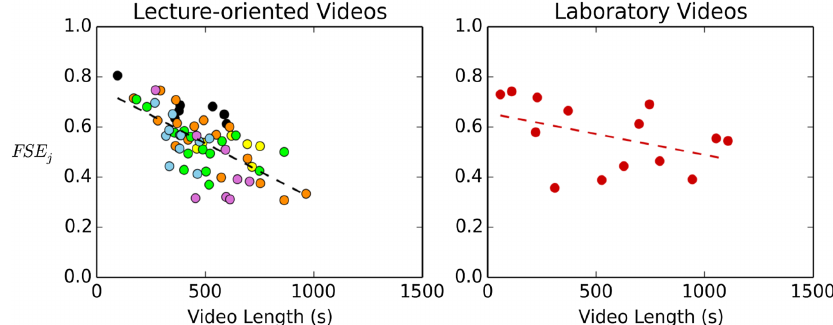
FIG. 5. Video length vs fraction of students accessing more than 99% of the given video (FSE j ). Each data point represents one single video in the course. The lecture-oriented videos are color coded based on different topics, with black, orange, yellow, green, blue, and purple representing the 1st to 6th topics presented in Table II, respectively. The trend lines for all lecture-oriented videos combined and all laboratory videos combined are y ¼ − 0 . 000 447 x þ 0 . 758 and y ¼ − 0 . 000 167 x þ 0 . 655 , respectively. The figure shows that the fraction of students accessing the entirety of a video decreases when videos become longer in length. Moreover, this trend is more prominent for the lecture-oriented videos than the laboratory videos.